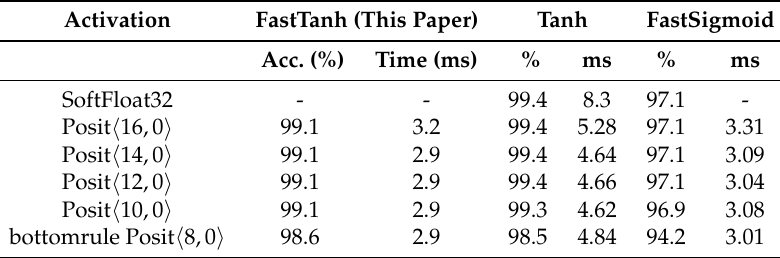
Table 6. Comparison using Posits for the MNIST dataset for three different activation functions: fast approximated version of Tanh (FastTanh), exact Tanh, and FastSigmoid. Accuracy of the neural network and mean sample inference time are reported.